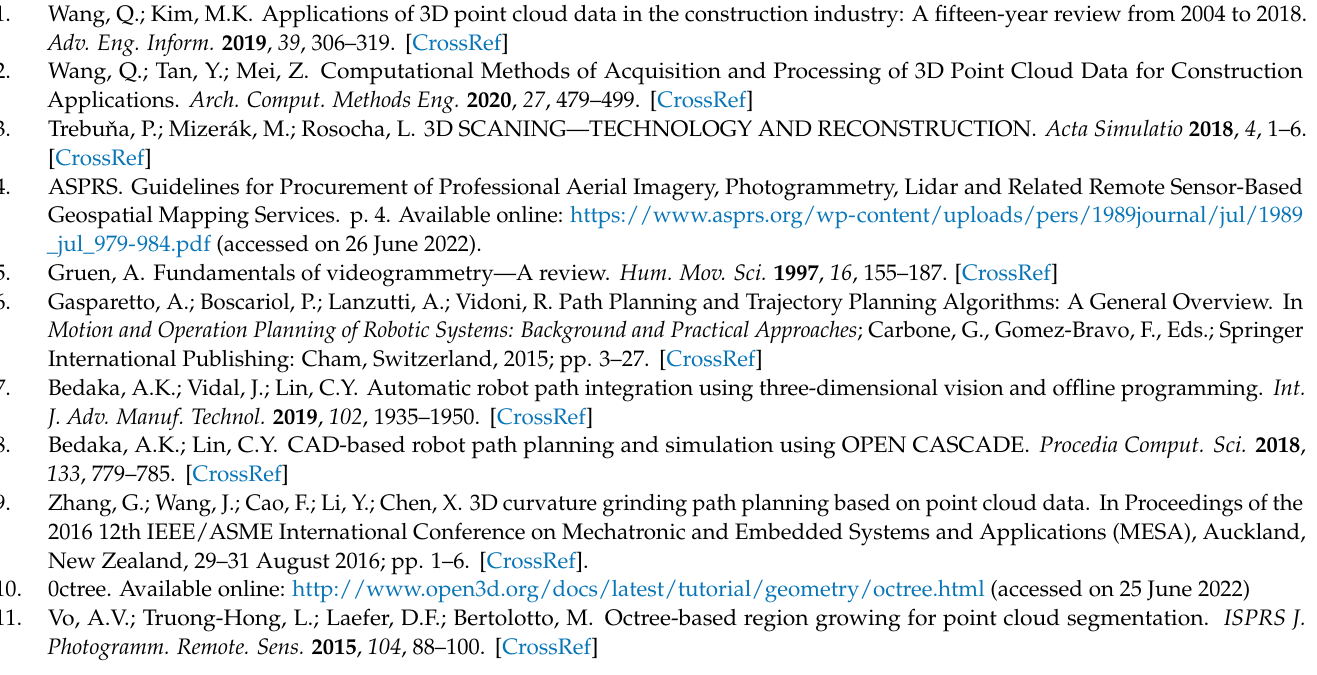
Tableware in Ceramic 4.0 by High Pressure Casting Robot work cell) Project with reference